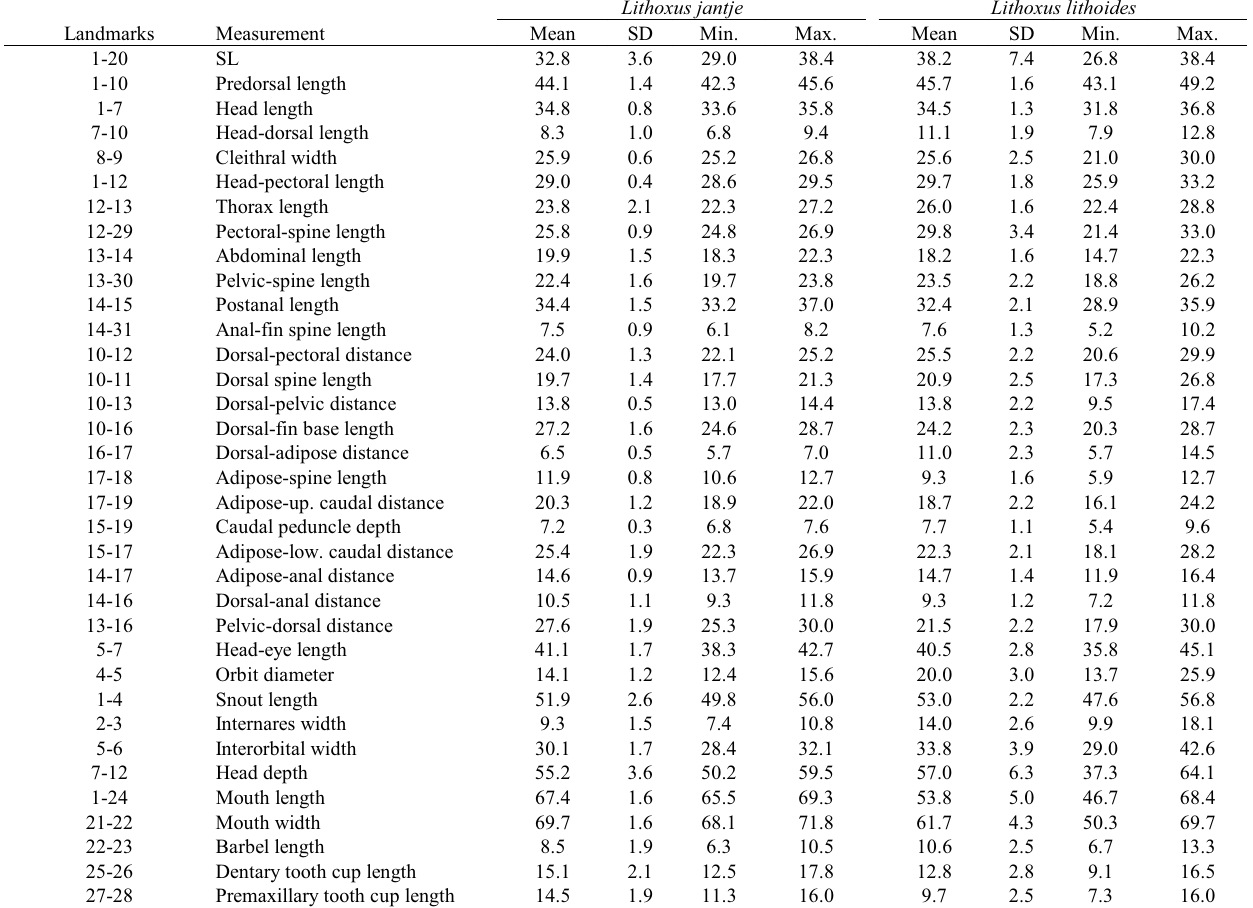
Table 1. Morphometric data for Lithoxus jantjae and L. lithoides . Landmarks are as illustrated in Armbruster (2003).